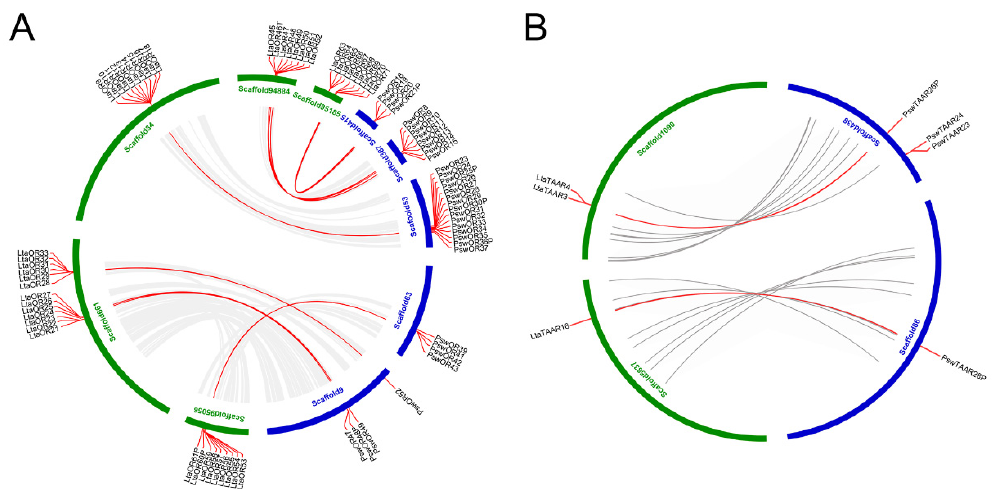
Figure 6. Identification of orthologous blocks between the Mariana snailfish and Tanaka’s snailfish. ( A ) Six pairs of OR orthologous blocks are anchored by 13 pairs of OR genes linked with orange lines. (B ) Two pairs of TAAR orthologous blocks are anchored by two pairs of TAAR genes linked with orange lines. Scaffolds from Mariana snailfish and Tanaka’s snailfish are indicated by blue and green, respectively. Tandem duplicated genes are indicated with orange lines along its own scaffold.